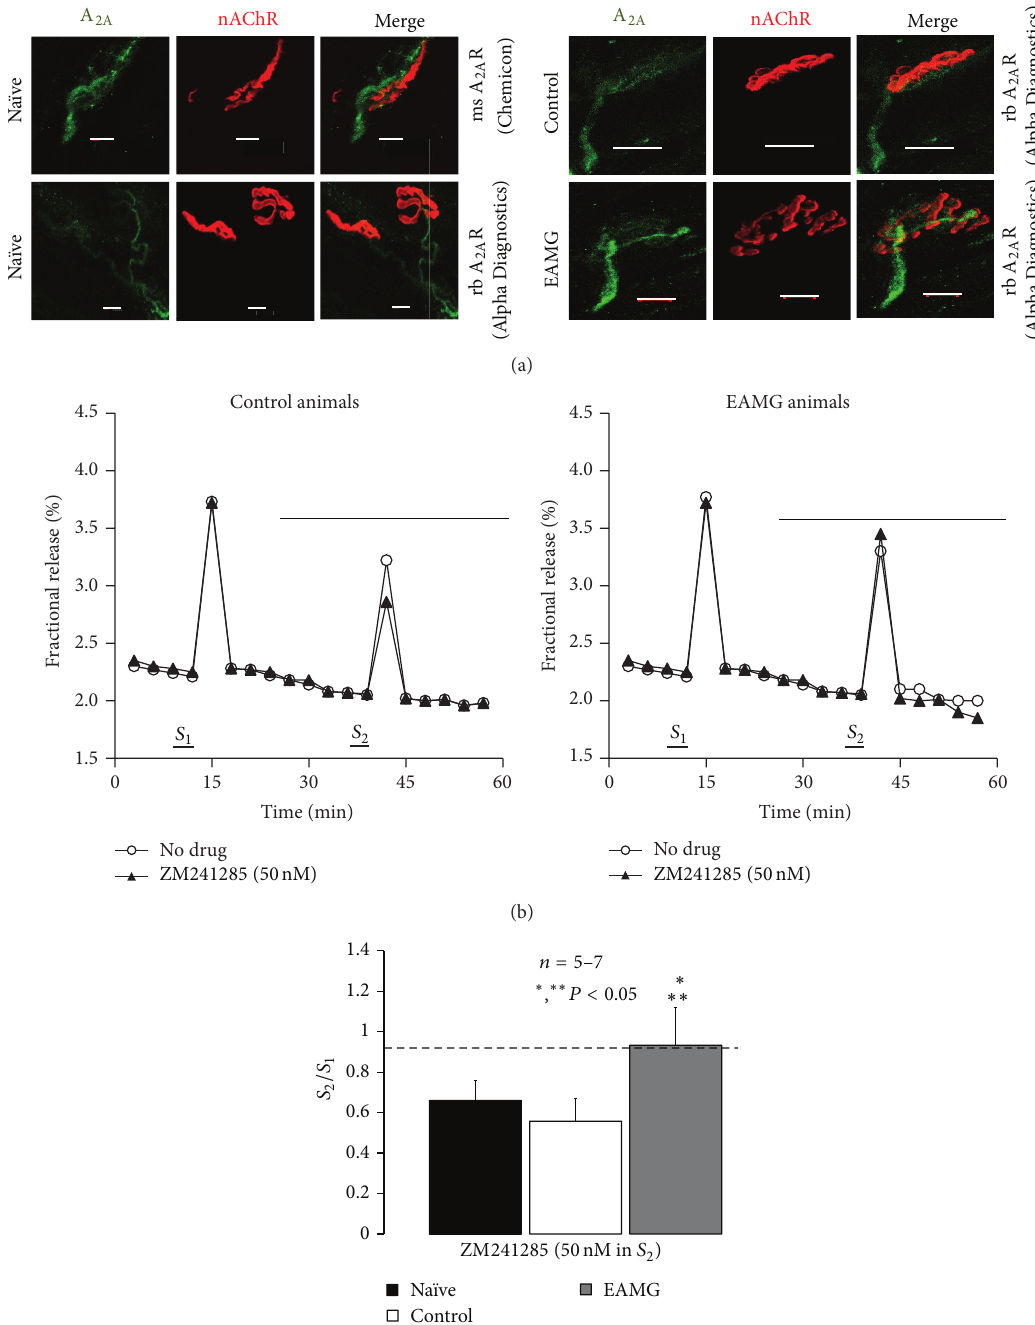
Figure 4: Tonic activation of A 2 R is significantly impaired at motor endplates of myasthenic rats. (a) Confocal micrographs showing A R ( green ) on motor endplates from rat hemidiaphragms labeled with TMR- 𝛼 -BTX ( red ) from na¨ıve, control, immunoreactivity against A 2 A R antibodies, AlphaDiagnostics (A2aR21-P) and Chemicon (05-717, Clone 7F6-G5-A2), and EAMG rats. Scale bar: 10 𝜇 m. Two distinct A 2 A were used was indicated. (b) Time course of tritium outflow from phrenic nerve terminals from control and EAMG animals taken from R antagonist, ZM241285 (50nM) (filled typical experiments in the absence (no drug, open circles) and in the presence of the selective A 2 A triangles). [ 3 H]-ACh release was elicited by stimulating the phrenic nerve trunk with 750 pulses delivered with a frequency of 5Hz at the indicated times ( 𝑆 1 and 𝑆 2 ). ZM241285 (50 nM) was applied 15 min before 𝑆 2 . (c) Modification of the 𝑆 2 /𝑆 1 ratio caused by ZM241285 (50 nM) in na¨ıve, control, and EAMG rats. Each column represents pooled data from five (na¨ıve and control) and seven (EAMG) animals. The vertical bars represent mean ± SEM. ∗ , ∗∗ 𝑃 < 0.05 (one-way ANOVA followed by Dunnett’s modified 𝑡 -test) when compared to na¨ıve and control (CFA)